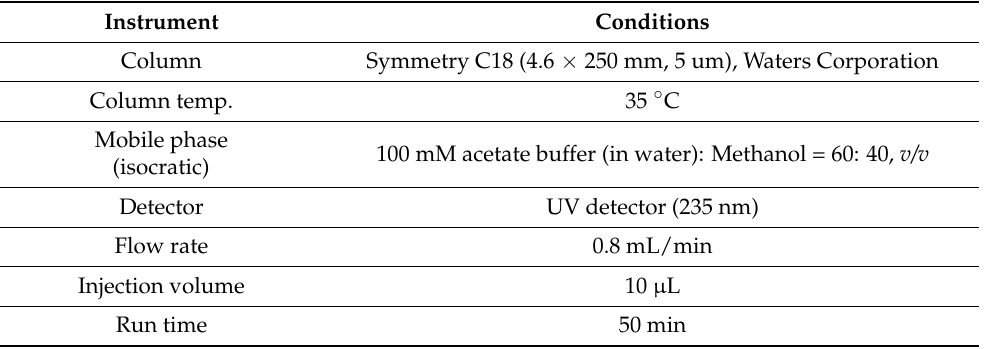
Table 1. HPLC condition for analysis of glutamic acid and